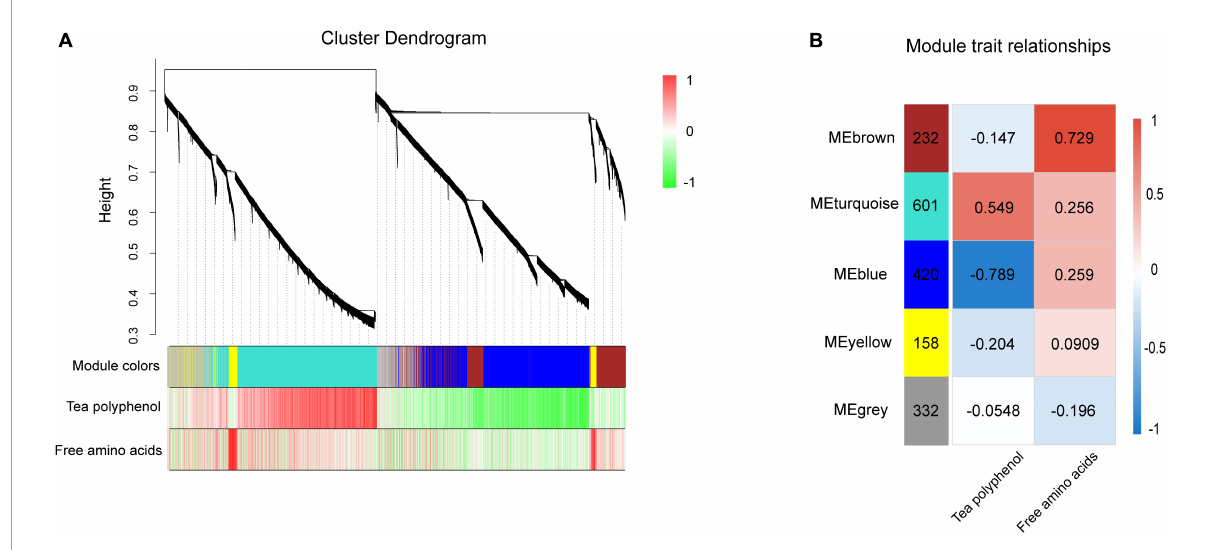
FIGURE6 WGCNA of genes in tea leaves under different NH 4 + treatments. (A) Gene cluster dendrogram and relationships between the contents of TP, AA and modules. According to the expression trend of transcripts, transcripts were divided into modules, where branches represent a gene, and a color represents a module. (B) Heatmap of correlation between module and trait. The vertical axis represents different modules, the left column of numbers represents the number of genes in the module and each set of data on the right represents the correlation coefficient.